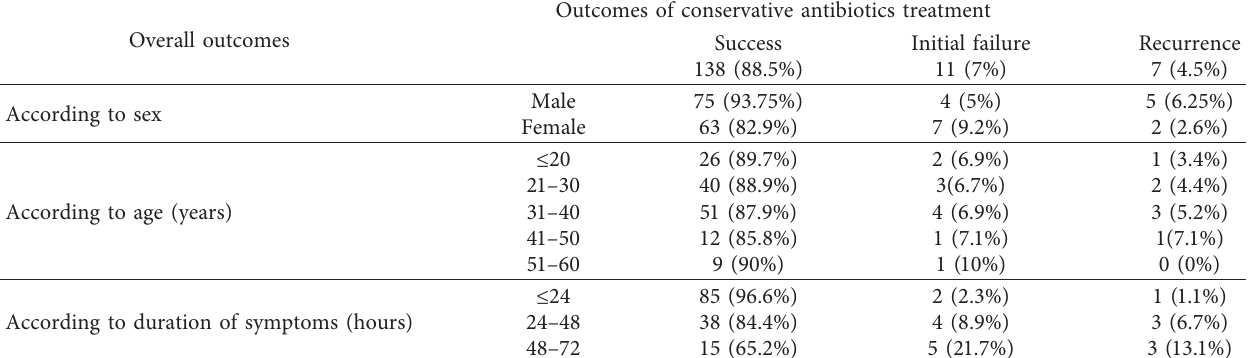
Table 4: Outcomes of conservative antibiotic treatment of simple and uncomplicated